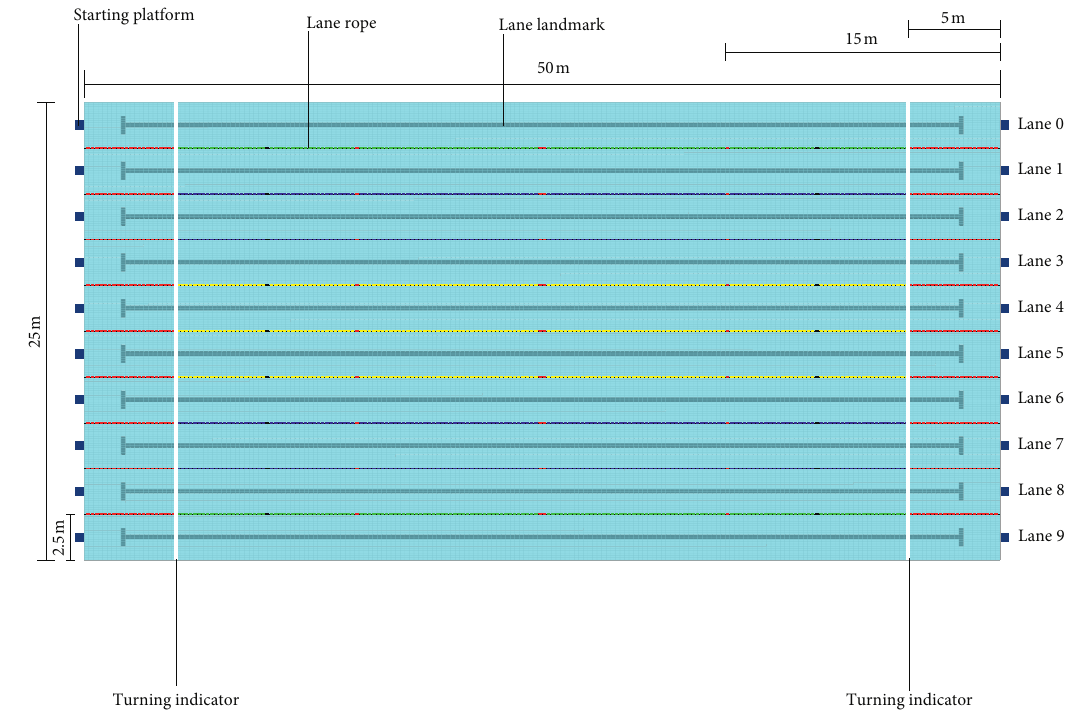
Figure 1: Conventional dimensional measures recognized by FINA for 50meters Olympic pools.